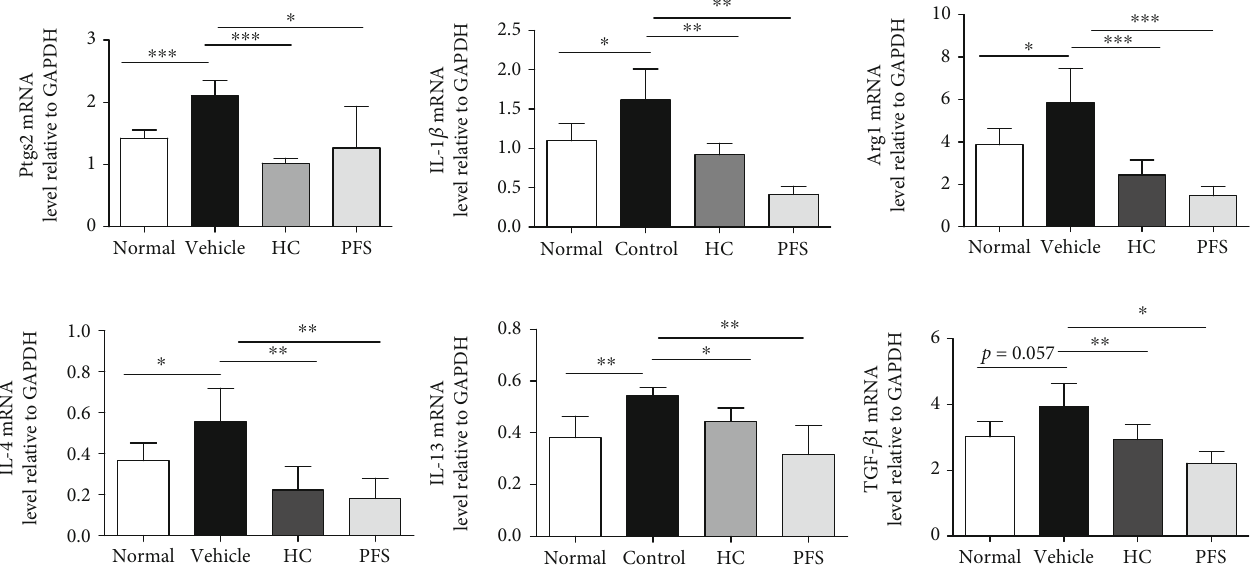
Figure 6: PFS inhibited mRNA expression of M1/2 macrophage in oxazolone-induced BALB/c mice (ten-time challenge). Expression of mRNA levels was determined by RT-PCR. The grey values were normalized to GAPDH and expressed as mean ± SD ( n = 6 ), ∗ p < 0 : 05 , ∗∗ p < 0 : 01 , ∗∗∗ p < 0 : 001 versus the vehicle